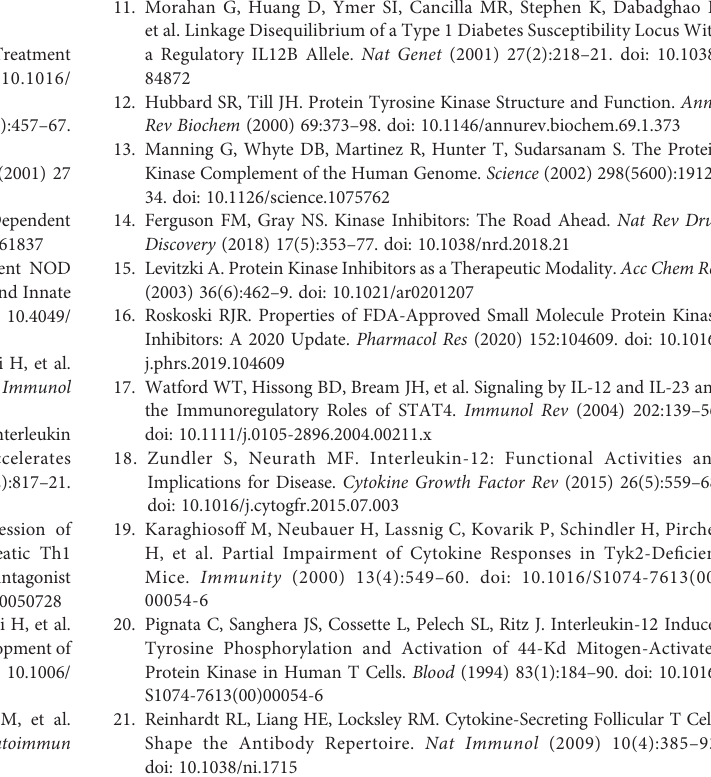
Supplementary Figure 2 | Gating strategy for fl ow cytometry analysis of T cells. (A) Gating of naïve CD4+ T cells in mouse splenocyte (upper panel); the purity of sortednaïveCD4+Tcells(downpanel). (B) GatingofTh1cellsinmouseCD4+Tcells. (C) Gating of naïve CD4+ T cells in human PBMC (upper panel); the purity of sorted naïve CD4+ T cells (down panel). (D) Gating of Th1 cells in human CD4+ T cells. PBMC, peripheral blood mononuclear cells. Supplementary Figure 3 | Sorafenib does not alter IFN- g expression in Th1 cell. (A, B) Flow cytometry analysis of IFN- g + Th1 cells treated with different concentrations of sorafenib ( m M) as indicated. Supplementary Figure 4 | Sorafenib does not alter T cell subsets in peripheral immunetissues ofprediabeticNODmice. Flowcytometryanalysis of the frequency of Th1, Th2,andTh17 cells inPLN (A) andsplenic (B) CD4+T cellsfrom vehicle-treated orsorafenib-treatedNOD mice. (C) Flow cytometryanalysis of the frequency ofTregs inPLNandsplenicCD4+Tcells,respectively.Sora,sorafenib;PLN,pancreaticlymph nodes. Data represent means ± s.e.m. and data were pooled from 2 or more independent experiments. n = 5-7 mice per group in each experiment. Supplementary Figure 5 | Sorafenib decreases activate Th1 cells in MLN and spleen of E. coli-infected mice. (A) Image of E coli on Luria-Bertani Agar plates from vehicle-treatedorsorafenib-treatedC57BL/6JmiceinjectedwithPBSorE.coli(1*107 CFU). Flow cytometry analysis of the frequency of Th1 cells in MLN (B) and splenic (C) CD4+ T cells from the three groups mice as indicated. Sora, sorafenib; MLN, mesenteric lymph node. Data represent means ± s.e.m.. n = 4 mice per group in this experiment. Statistical signi fi cance: *P <0.05 or **P <0.01 versus vehicle by t-test. Supplementary Figure 6 | Sorafenib does not alter T-cell subsets in peripheral immunetissuesofdiabeticNODmice.FlowcytometryanalysisofthefrequencyofTh1, Th2, and Th17 cells in PLN (A) and splenic (B) CD4 + T cells fromvehicle-treated or sorafenib-treated diabetic NOD mice. (C) Flow cytometry analysis of the frequency of Tregs in PLNand splenic CD4 + T cells, respectively. Sora, sorafenib;PLN, pancreatic